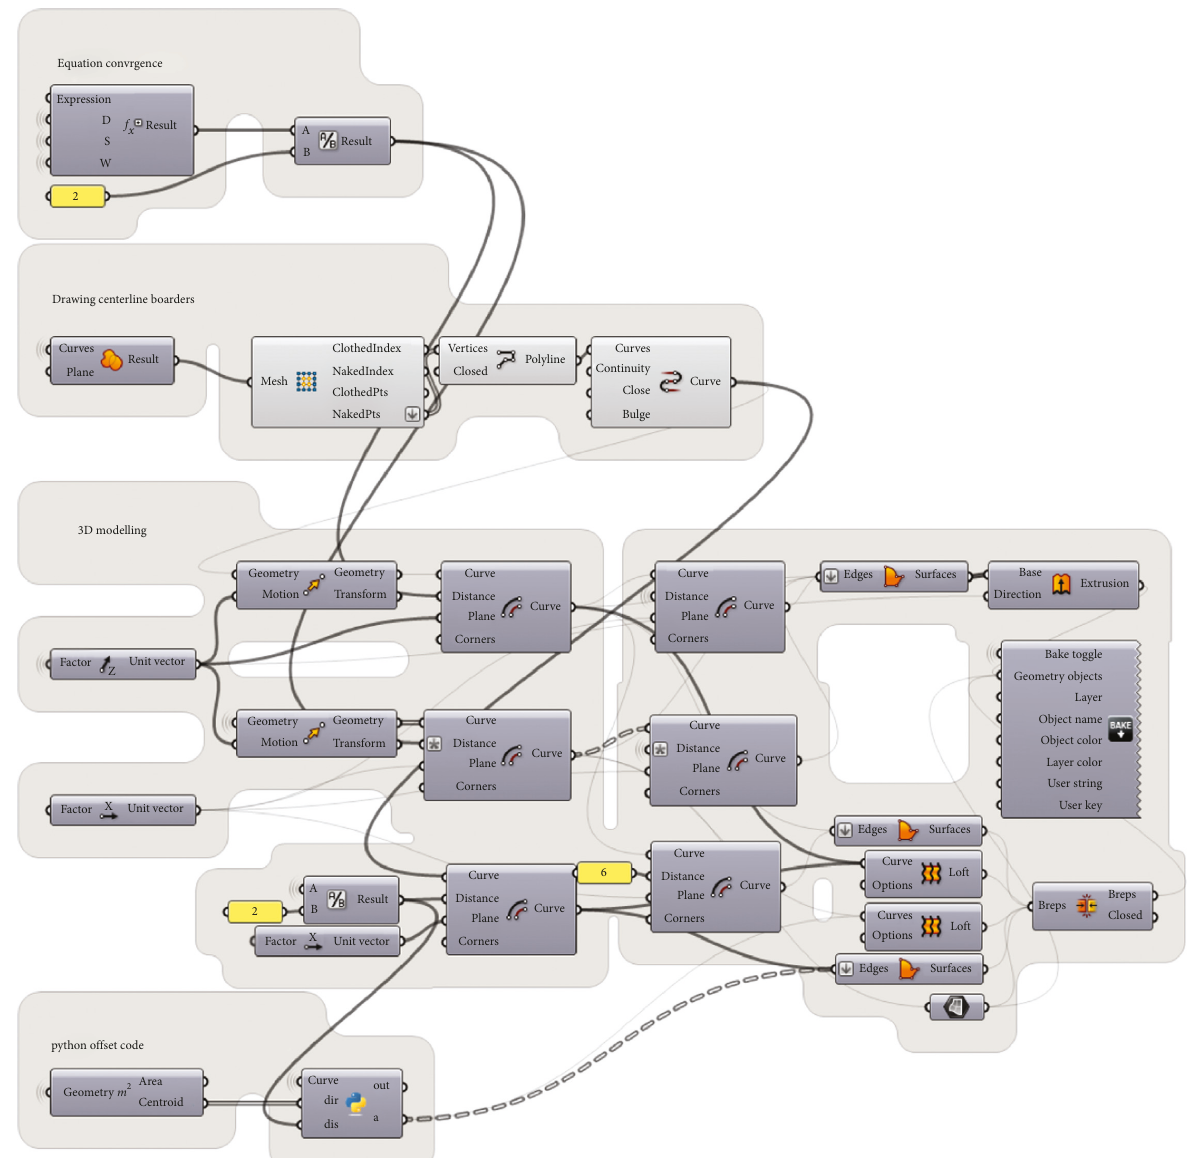
Figure 5: Cave-in hazard identification and preventive measure